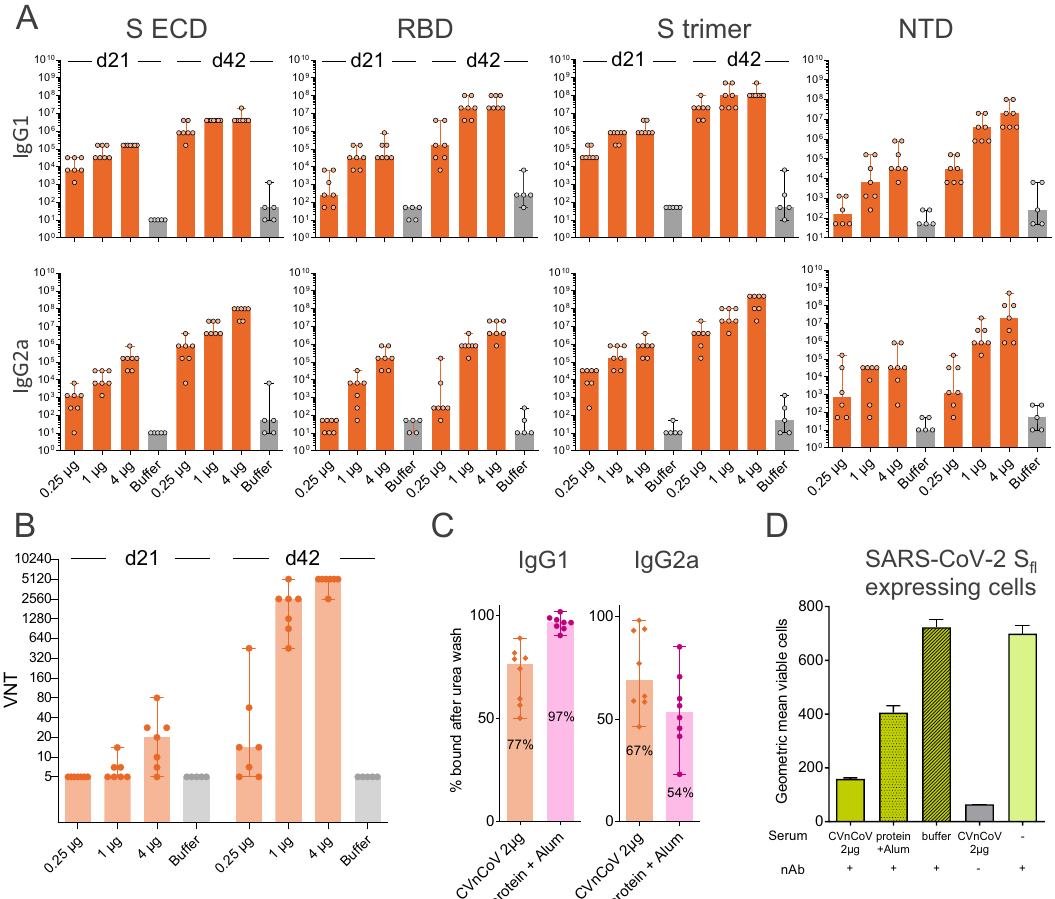
Fig. 3 CVnCoV elicits high titres of functional antibodies against SARS-CoV-2. Female Balb/c mice ( n = 7/group) were vaccinated IM with 0.25, 1 and 4 µg of CVnCoV on day 0 and day 21. Animals ( n = 5/group) vaccinated with NaCl (Buffer) served as negative controls. A Spike protein-speci fi c binding antibodies binding to S ECD , RBD, S trimer and NTD, displayed as ELISA endpoint titres for IgG1 and IgG2a for day 21 and day 42. B CPE-based VNTs in serum samples taken on day 21 and day 42. C Per cent of S ECD -binding IgG1 and IgG2a antibodies remaining using serum from animals vaccinated with 2 µg of CVnCoV or 1.5 µg Alum-adjuvanted S ECD upon 30 min wash in 8% urea compared to buffer wash. D S-speci fi c signal detectable on the surface of HeLa cells expressing full-length SARS-CoV-2 S upon incubation with fl uorescently labelled monoclonal neutralising antibody in the absence or presence of mouse serum. Serum employed was either from mice vaccinated with 2 µg of CVnCoV, 1.5 µg of Alum-adjuvanted protein or buffer. Each dot represents an individual animal, bars depict the median. S ECD S ectodomain, RBD receptor-binding domain of S, NTD N-terminal domain of S, nAb neutralising comparison, control animals infected with wild-type SARS-CoV-2 on day 0 developed VNTs of 1:191. A control group that received Alum-adjuvanted S ECD protein developed IgG antibodies but undetectable VNT levels (Fig. 4B). On day 56, 4 weeks after the second vaccination, all animals were challenged with 10 2 TCID 50 /dose of SARS-CoV-2 featuring D614G. While this infection dose is low compared to other studies that employed doses of 2 × 10 3 – 2 × 10 6 TCID 5030 – 36 , our results show robust levels of viral replication in the upper and lower respiratory tract (Fig. 4) as well as typical weight loss for this model